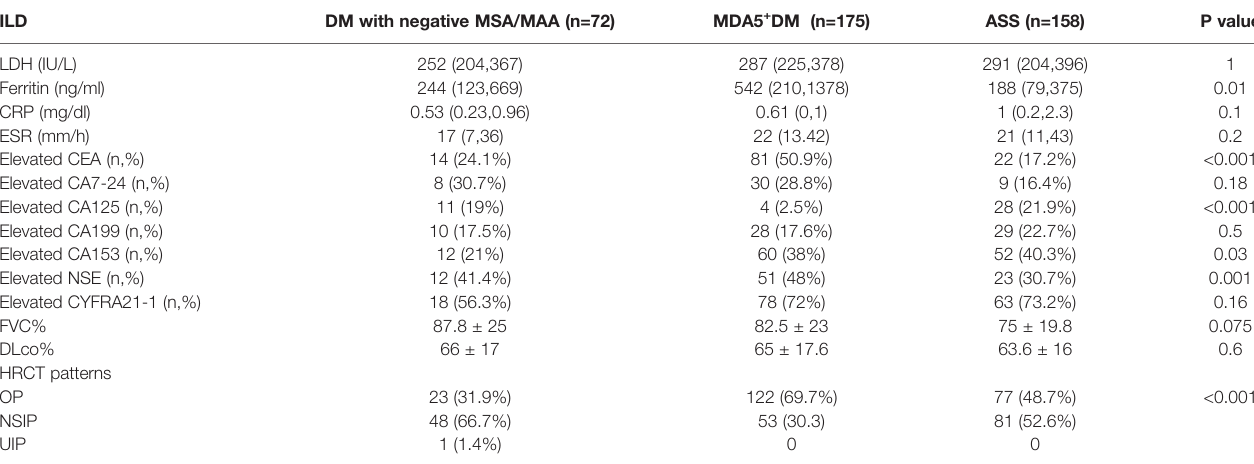
(Table 1 Breakdown): Continuous data were presented as M (mean) ± SEM (standard error of the mean), or medians (interquartile range). Binary data were presented as n (%) of the patients. DM, dermatomyositis; CK, creatine kinase; LDH, Lactate Dehydrogenase; FVC, Forced Vital Capacity; DLco, diffusing capacity for carbon monoxide; UIP, usual interstitial pneumonia; NSIP, nonspeci fi c interstitial pneumonia; OP, organizing pneumonia.